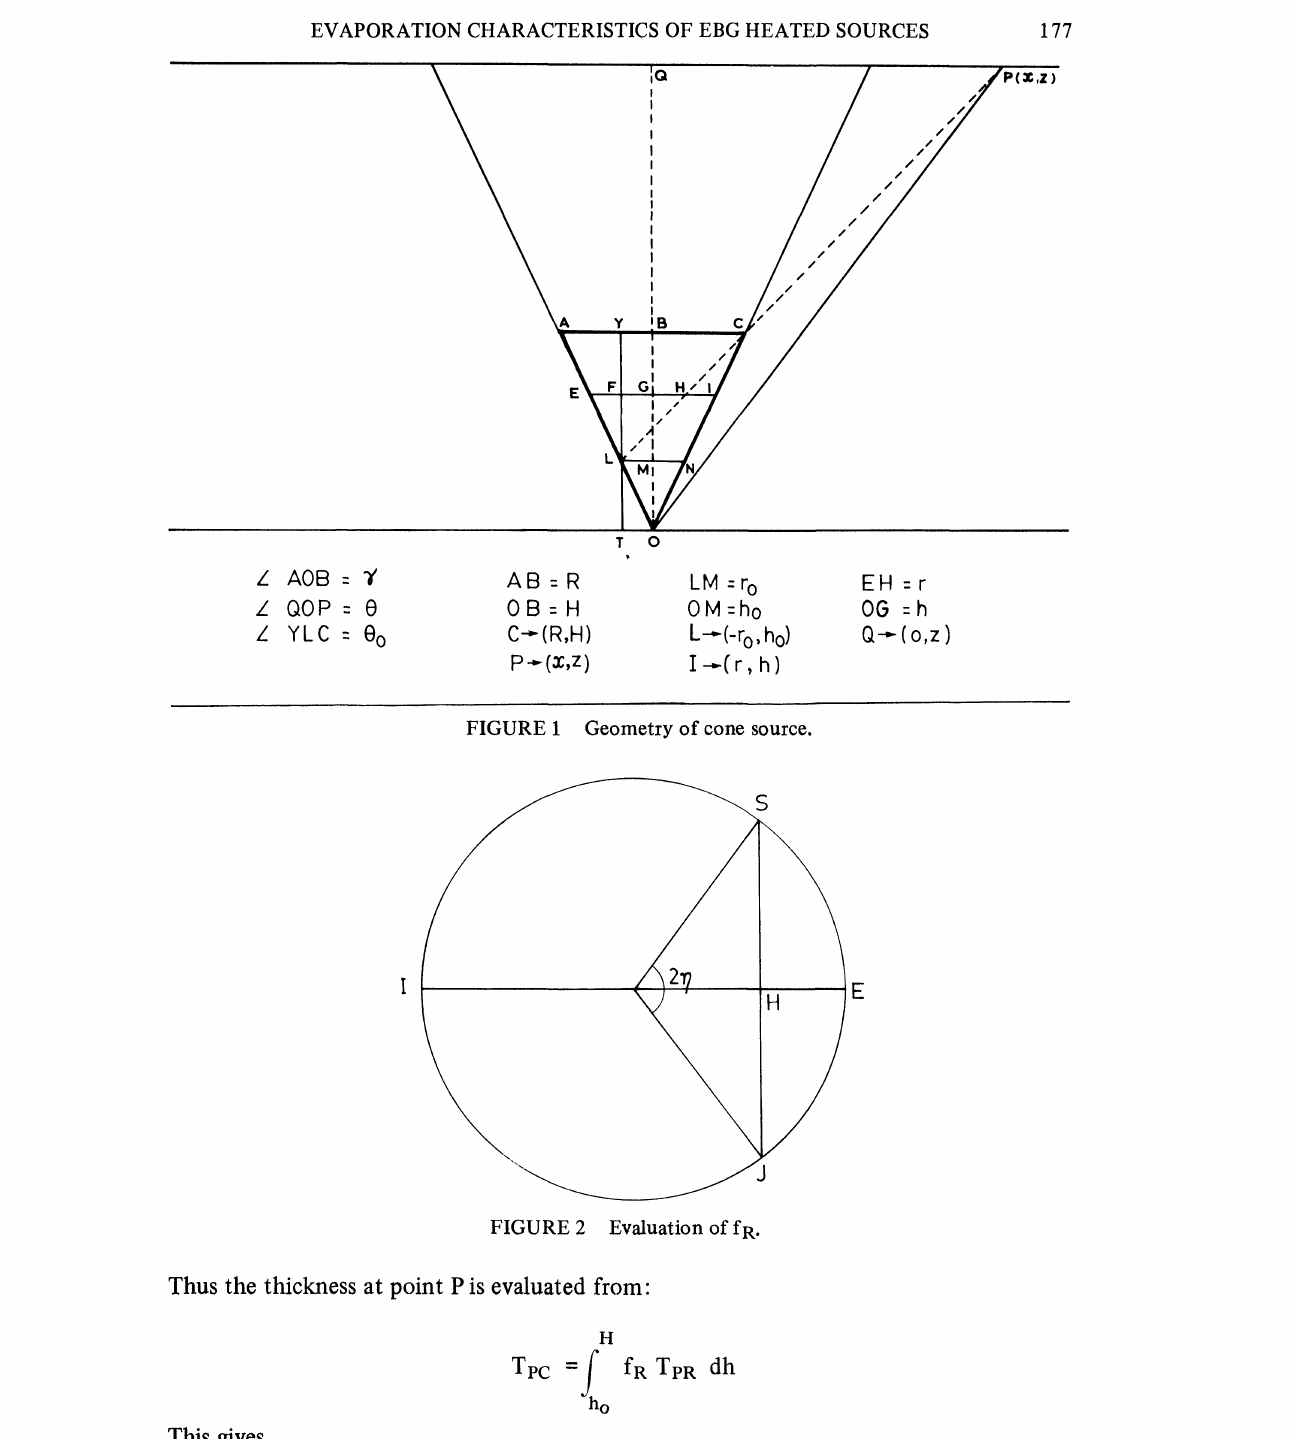
FIGURE 2 Evaluation of